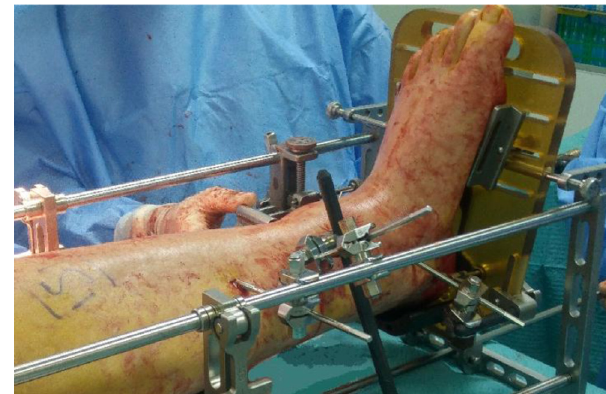
Figure 3. Tibial and talar pins. Standard